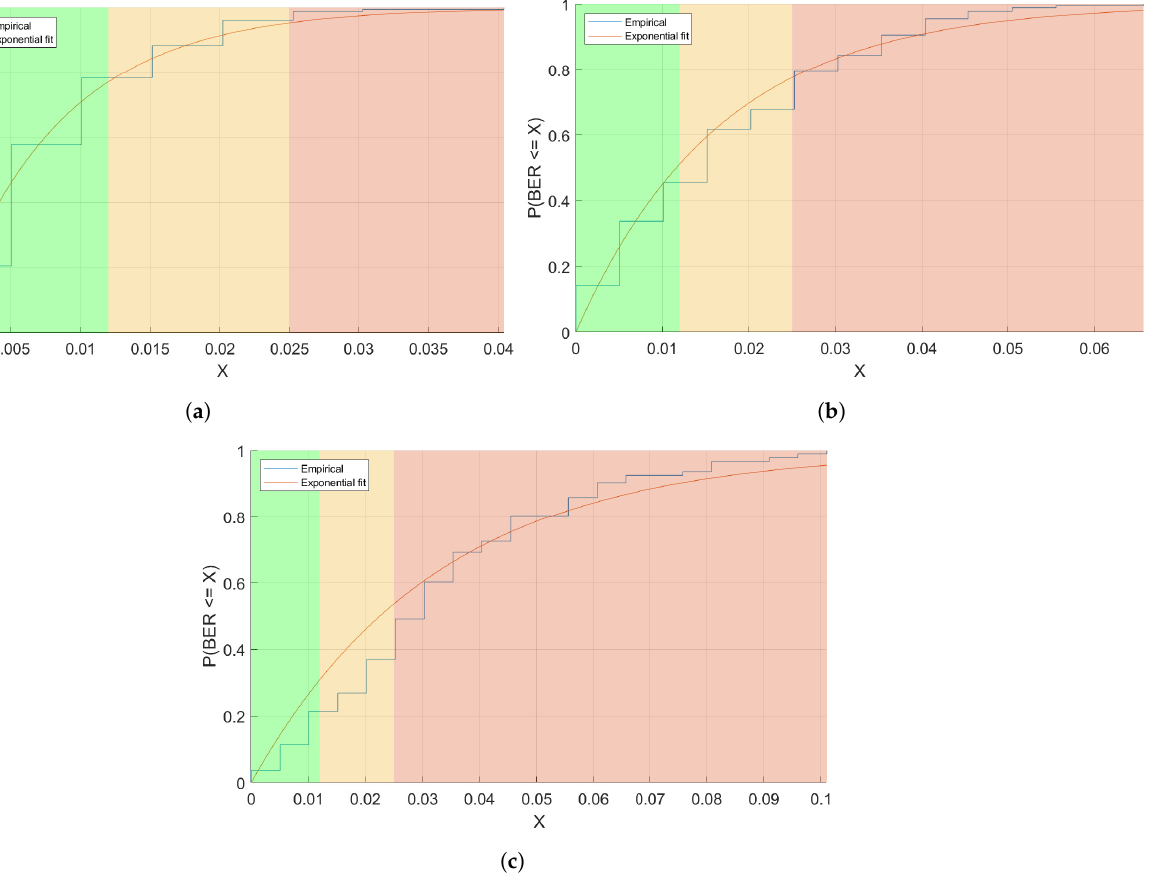
Figure 2. Examples of BER CDF fits for the stable link from node 4 to node 2 observed in topology 2 ( a ), the average link from node 3 to node 2 observed in topology 2 ( b ), and the challenging link from node 1 to node 3 observed in topology 1 ( c